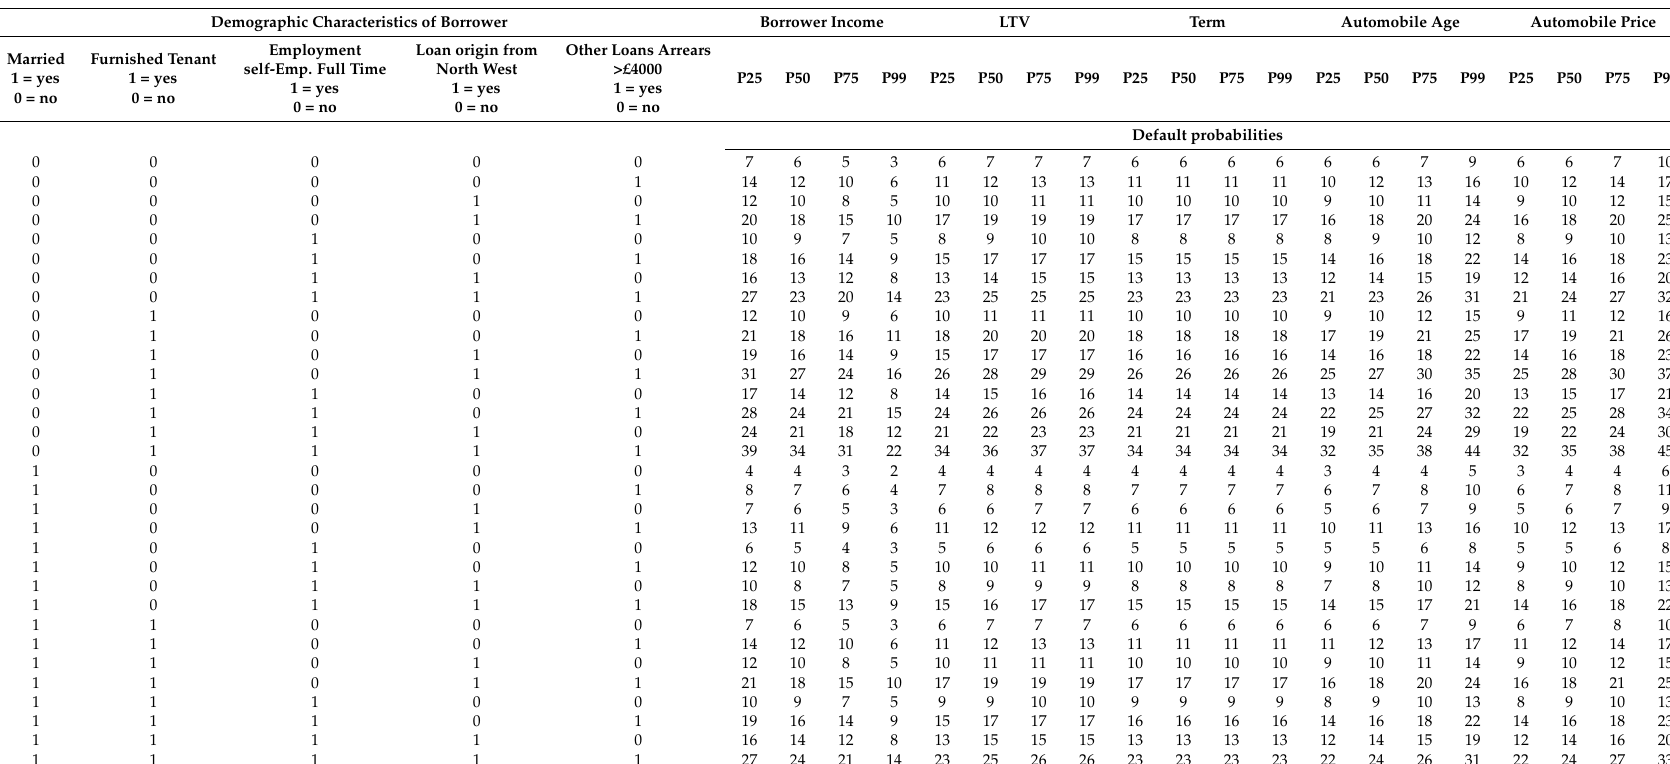
Table 5. Subprime borrower’s demographic, residential, employment status, loan origination area, other loans arrears, and predicted default